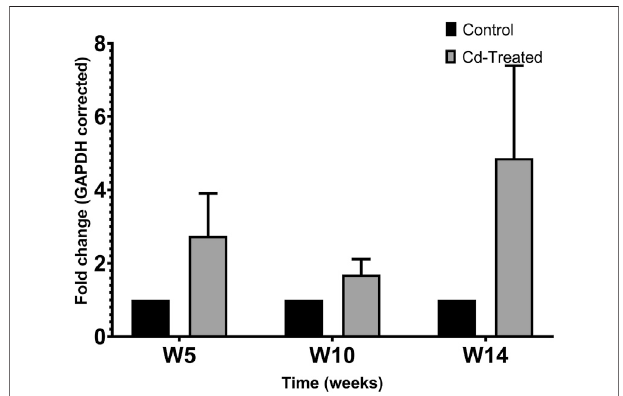
FIGURE 2 | Effect of Cd-treatment on expression of MMP-2 in heart tissueof male Sprague-Dawley rats. Protein expression datawerenormalized against the expression of GAPDH and expressed as mean ± S.E.M of fold- changes compared to the control ( n (cid:2) 8).